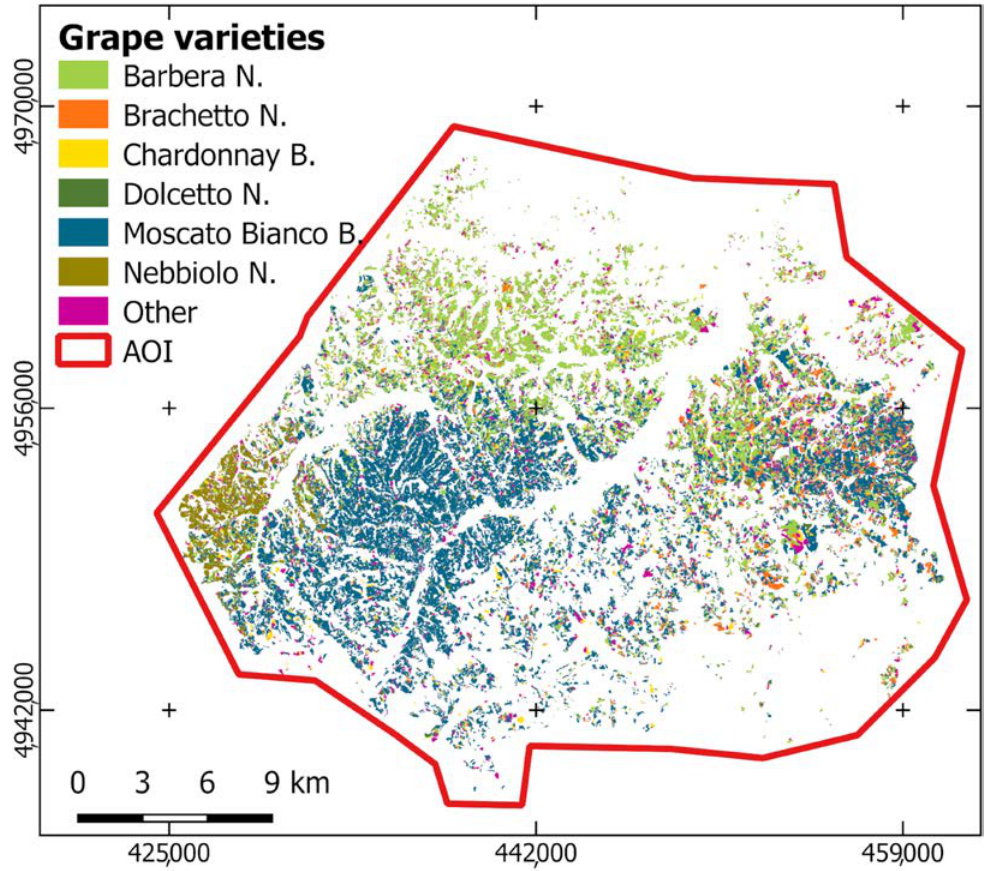
Figure 2. Map showing spatial distribution of grape varieties in the study area. (EPSG: 32,632 WGS 84 UTM zone 32N).